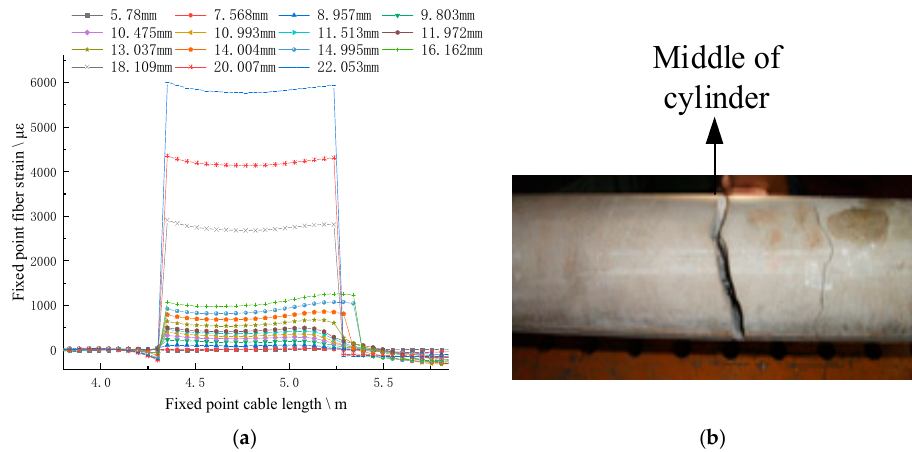
Figure 7. Strain curve of FP fiber ( a ) compared with the actual anchor drawn deformation. ( a ) The strain curve of FP fiber; ( b ) the actual deformation of concrete column.